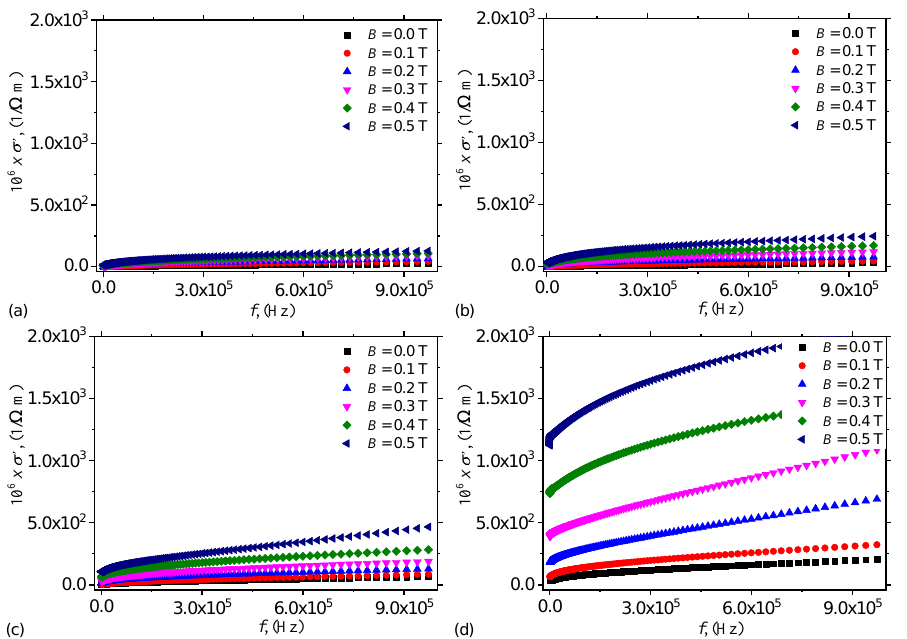
Figure A2. Variation of electrical conductivity σ (cid:48) with frequency f , at fixed values of magnetic flux density B . ( a ) hMAC. ( b ) hEMAC 1 . ( c ) hEMAC 2 . ( d ) hEMAC 3 .